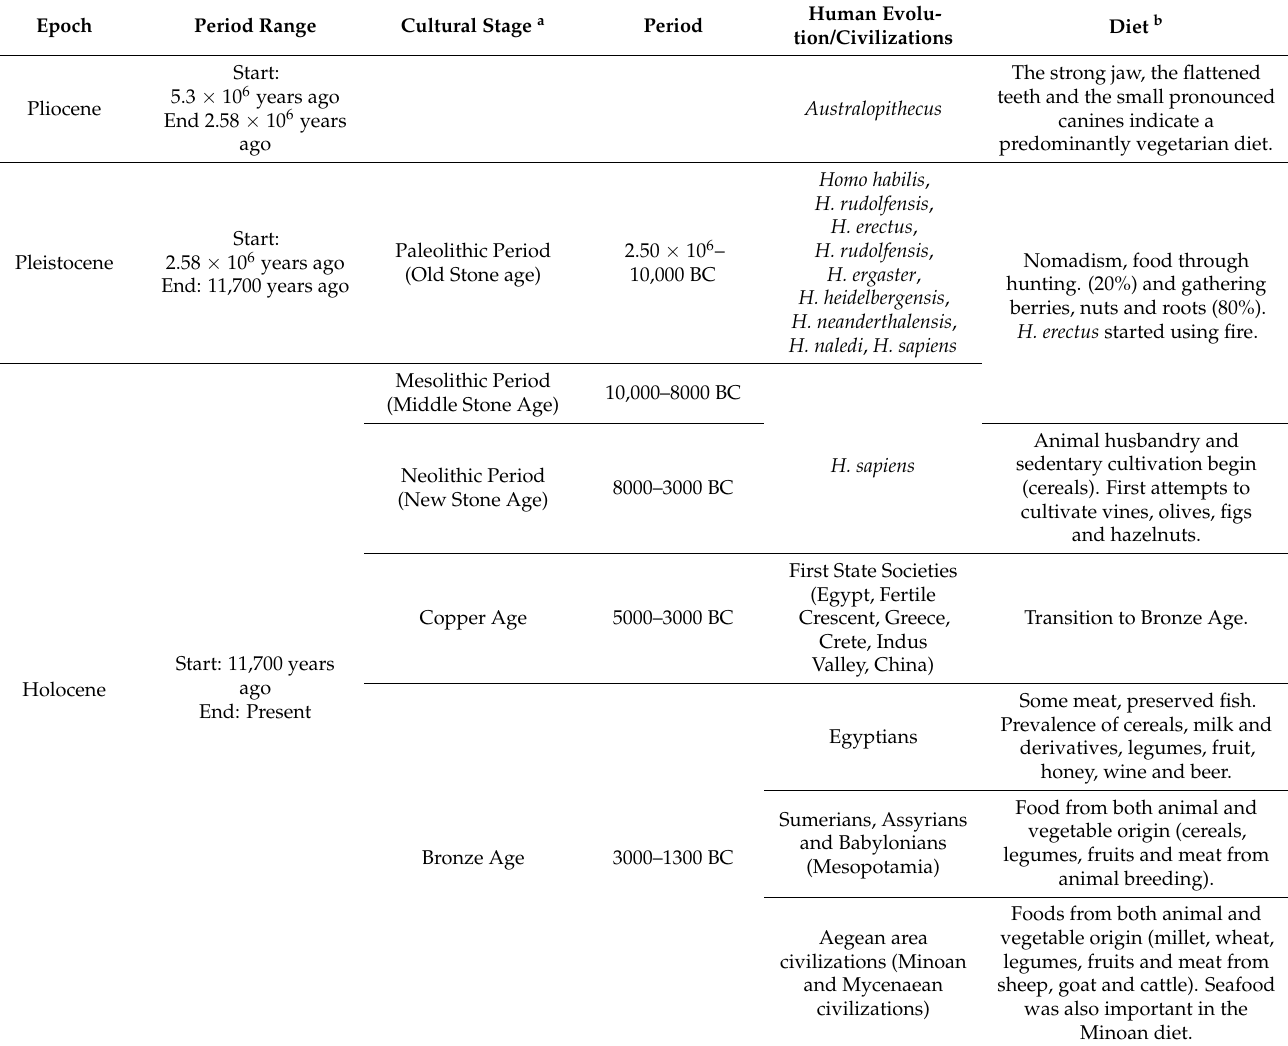
Table 2. Evolution of cultures, main civilizations, and dietetic